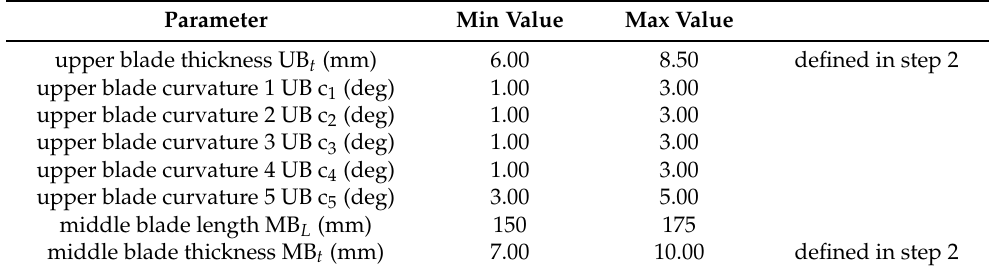
Figure 5. Geometric parameters of MyFlex- γ varied in the 2D FE model of the design phase —see Table 3.